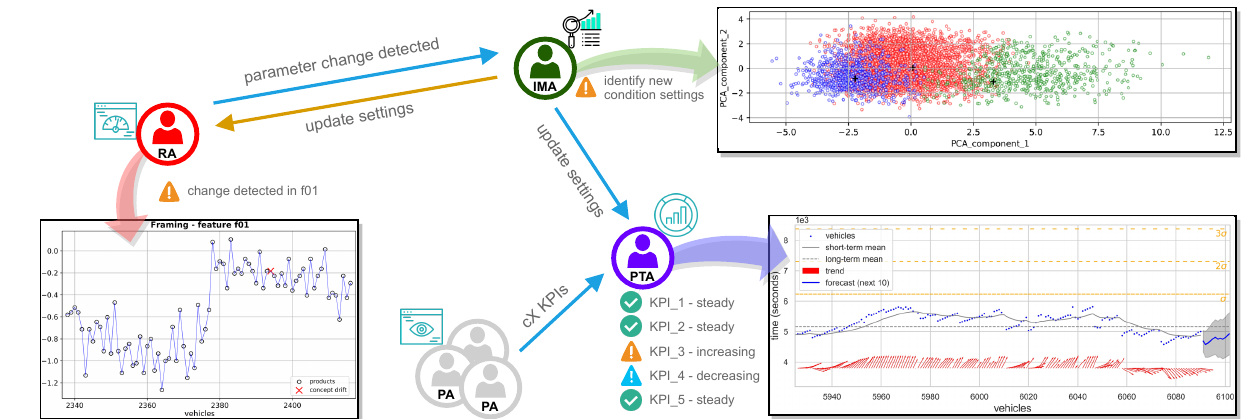
Figure 10. Interactions among agents to support the detection of changes in the measured parameters that require updating the monitoring